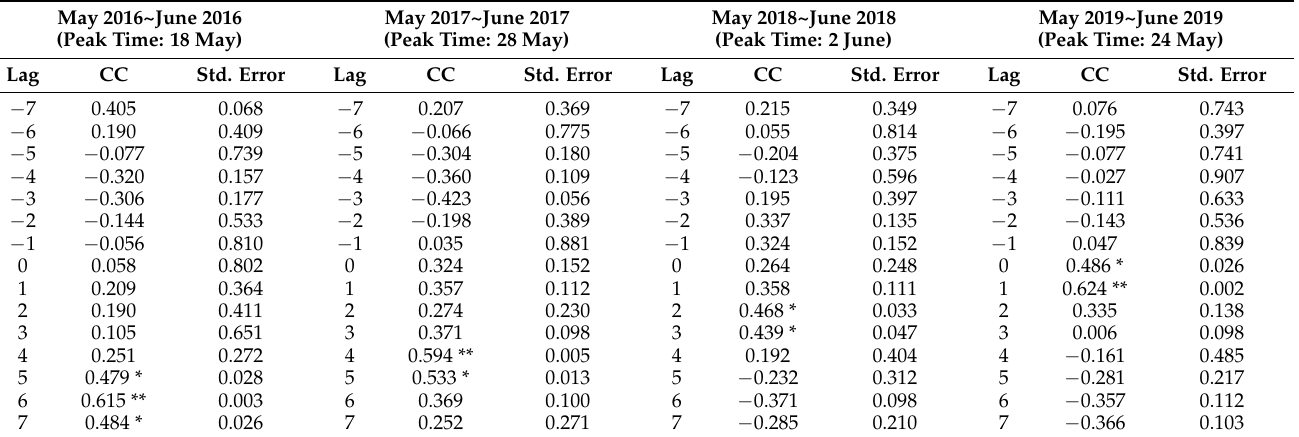
Table 2. Lag correlation coefficient between public concern and O 3 concentration for different ozone pollution